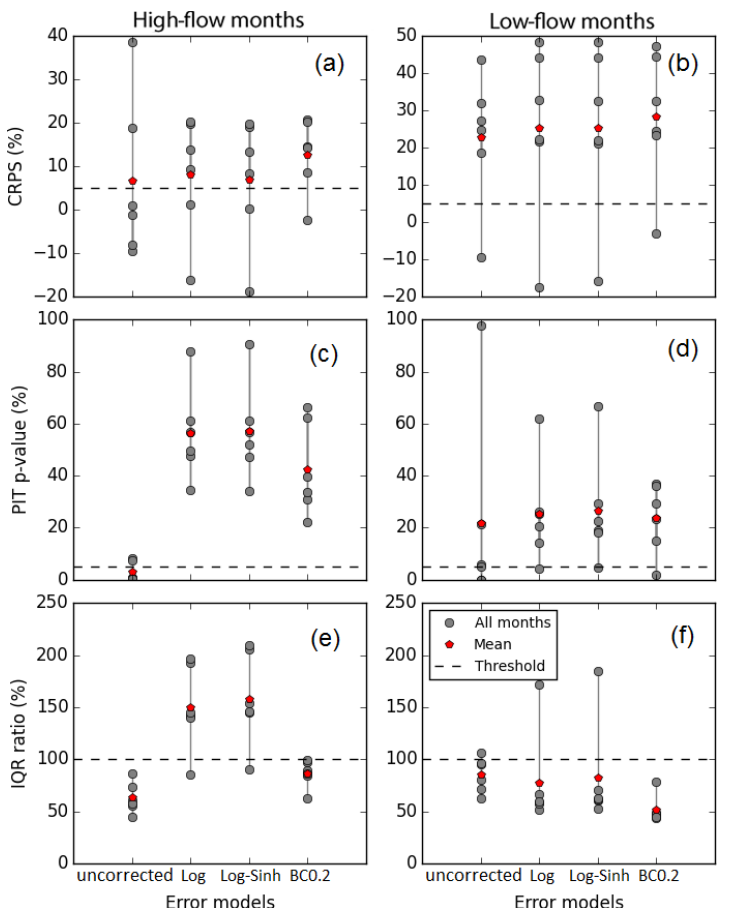
Figure 9. Seasonal streamflow forecast skill scores at Dieckmans Bridge catchment, computed from the time series shown in Fig. 8 for 6 high-flow months and 6 low-flow months.